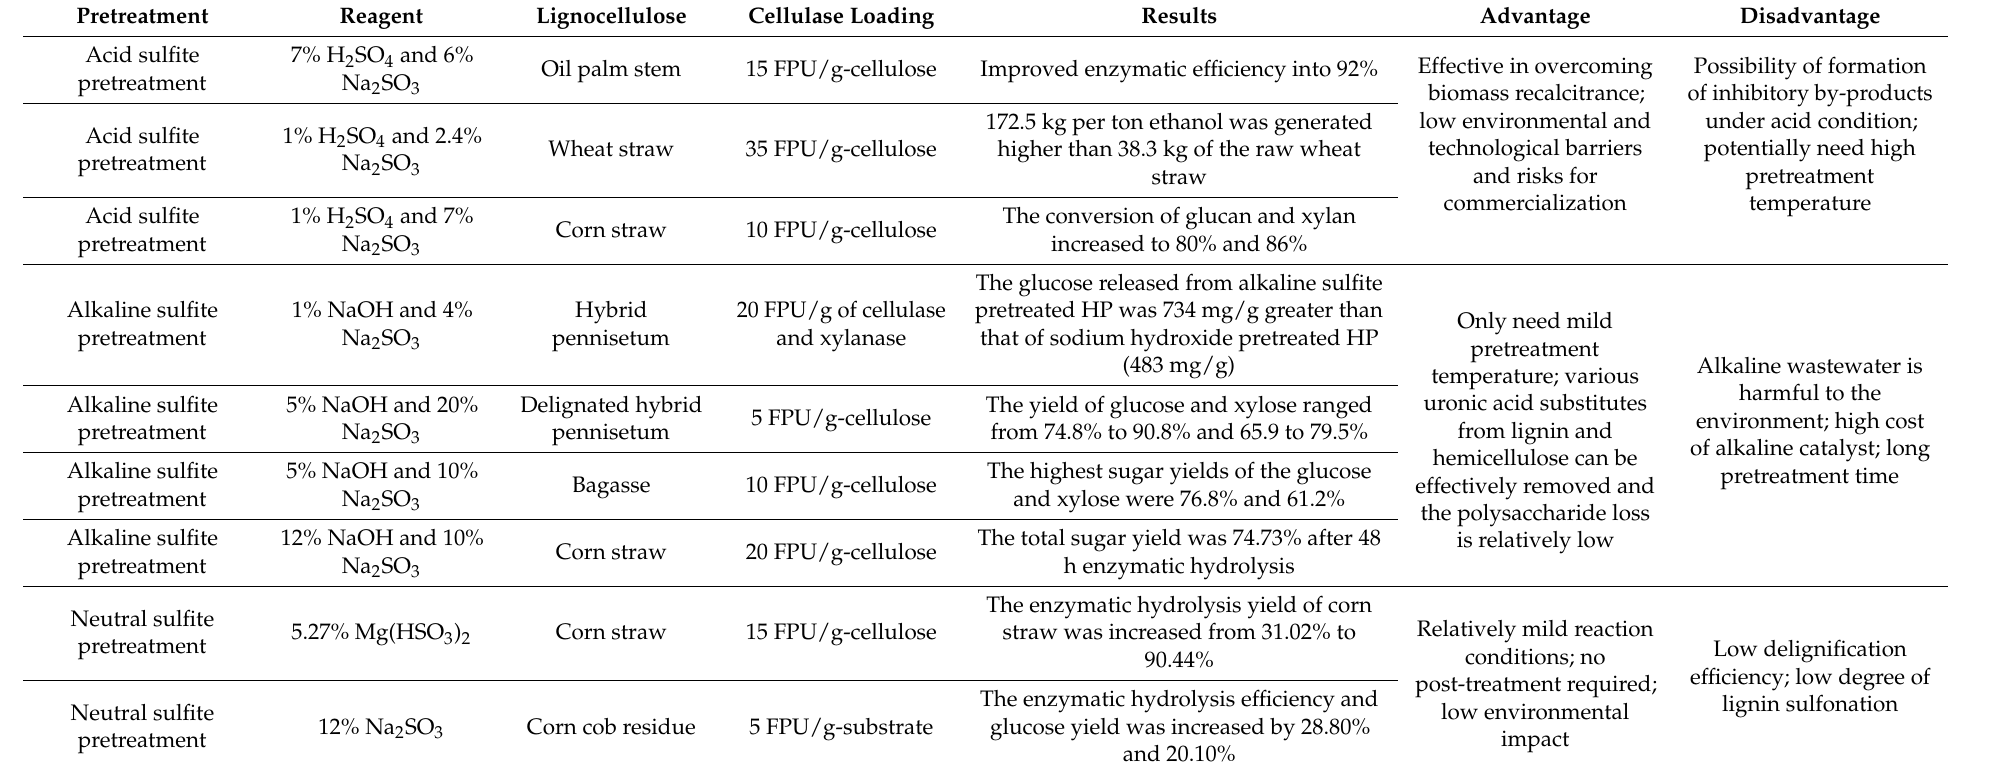
Table 1. The over review of sulfite pretreatment to increase enzyme hydrolysis efficiency of